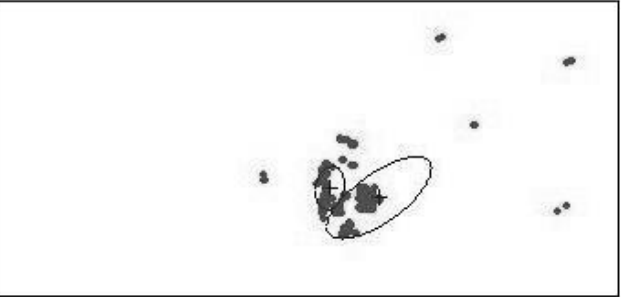
Figure 3. Illustration of Gaussian Mixture Models for Input image sequence of Fig- ure